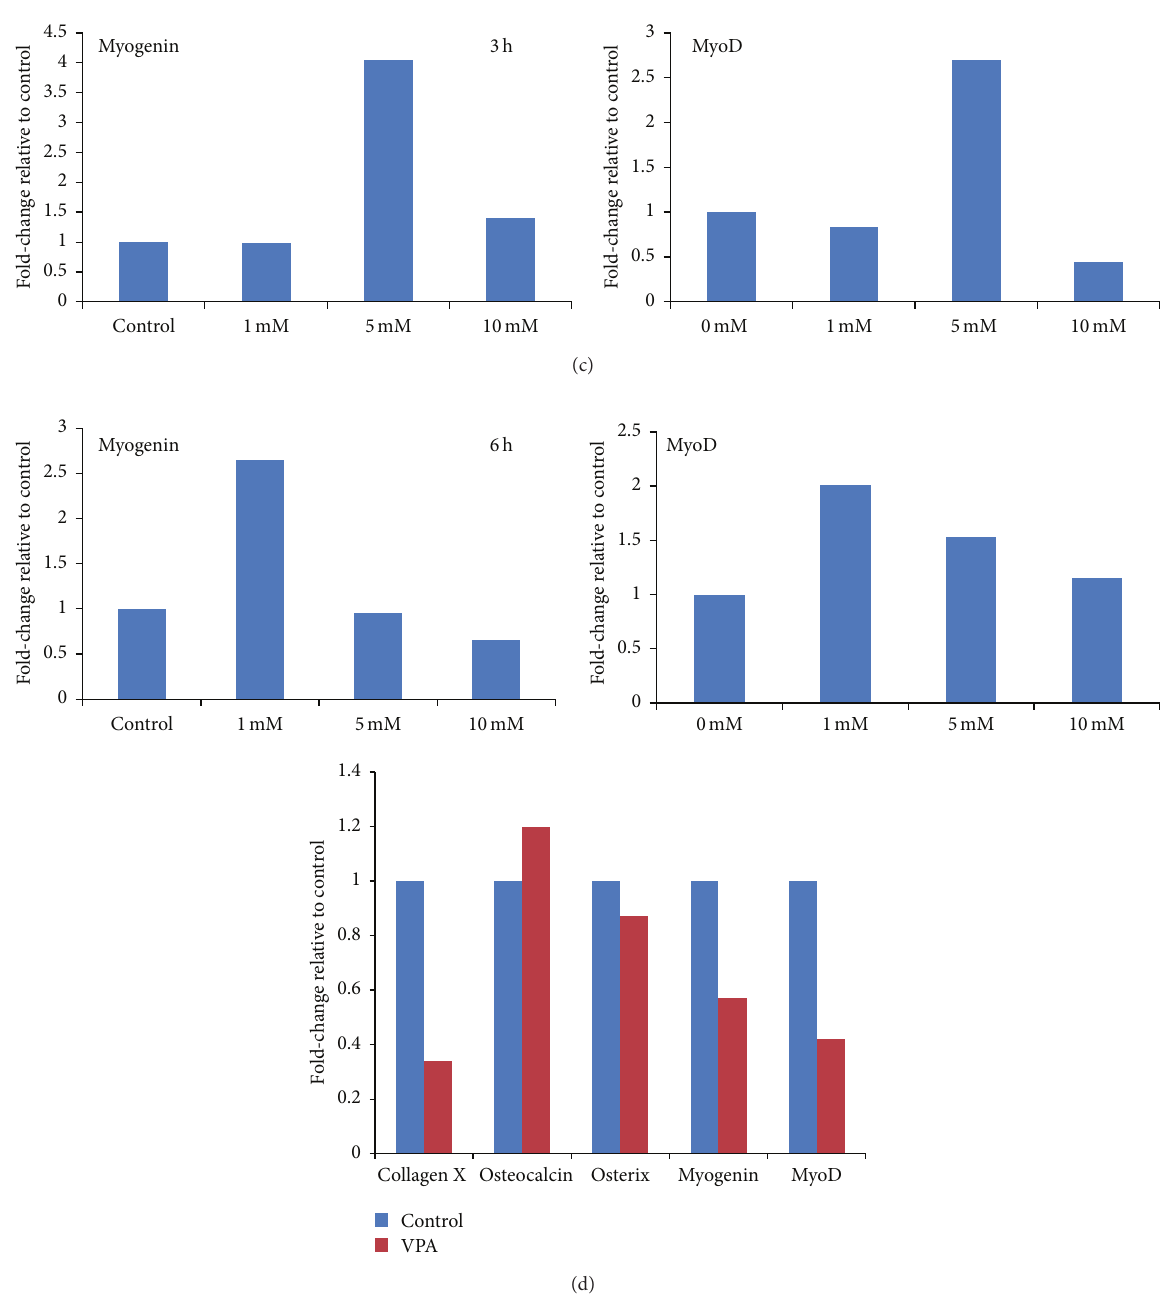
Figure 5: High VPA concentration for longer period downregulates the expression of osteogenic, chondrogenic, and myogenic markers. CB MSC were pretreated with or without (control) 1, 5, or 10mM VPA for 3h or 6 h. (a) The VPA was washed off and the cells were incubated in osteogenic and chondrogenic media. Differentiation into osteocytes was assessed after 3 weeks by staining for calcium deposits using Alizarin Red (top panel). Differentiation into chondrocytes was assessed after 3 weeks by staining for proteoglycans using Alcian Blue (bottom panel). (b) The expression of osteogenic markers (osterix and osteocalcin) and chondrogenic marker (collagen type X) was determined by gel-based RT-PCR using GAPDH as internal loading control. (c) The expression of myogenic markers (myogenin and MyoD) was evaluated by qRT- PCR using 18S as internal calibrator. The data is representative of two independent experiments. (d) CB-derived MSC were treated with or without (control) 5 mM VPA for 3 h and induced to differentiate the osteogenic, chondrogenic, and myogenic lineages. The gene expression of collagen type X, osteocalcin, osterix, myogenin, and MyoD was examined by gel-based RT-PCR using GAPDH as internal loading